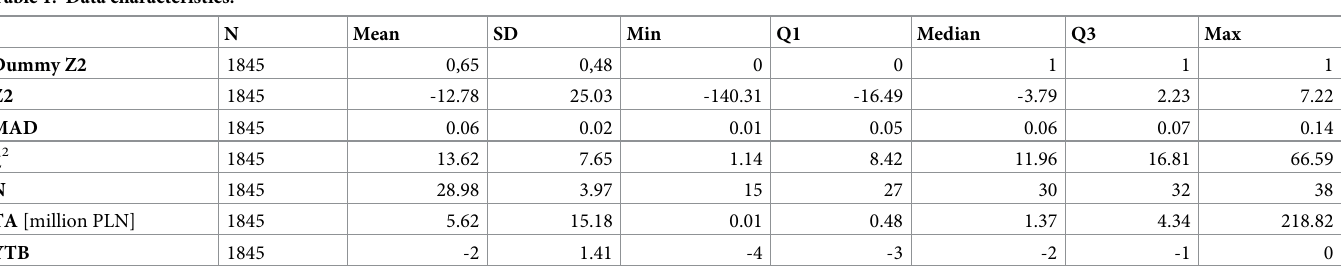
Table 1. Data characteristics.